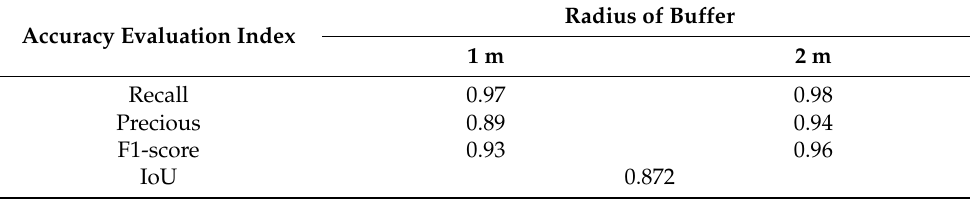
Table 4. Evaluation of parcel extraction effect.